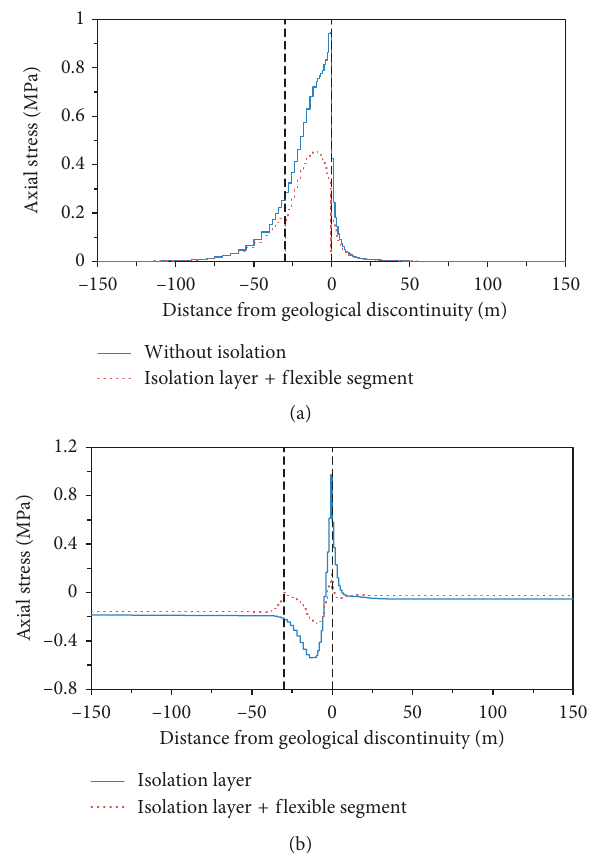
Figure 20: Seismic response of shield tunnel. (a) Longitudinal direction and (b) transverse